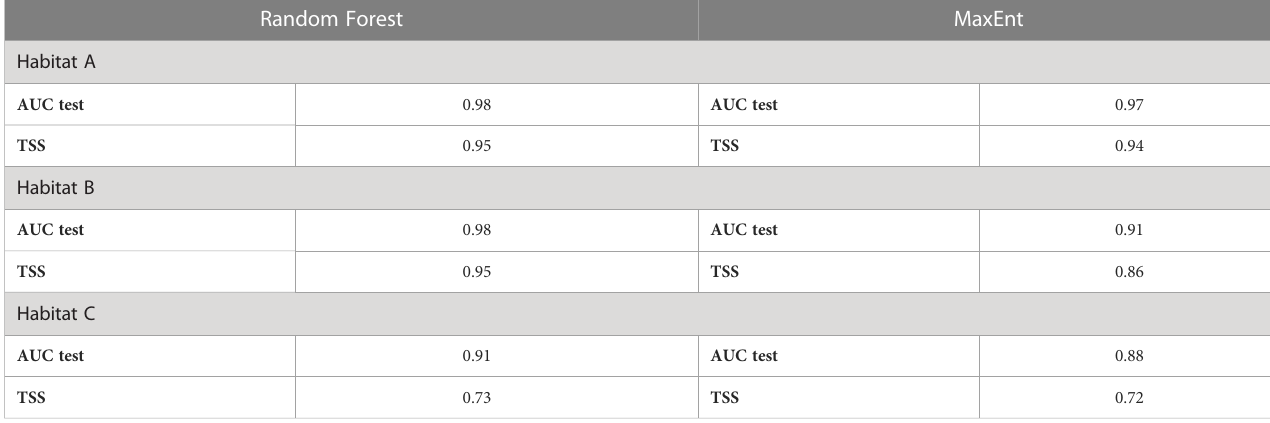
TABLE 4 Models accuracy evaluation using AUC test and TSS